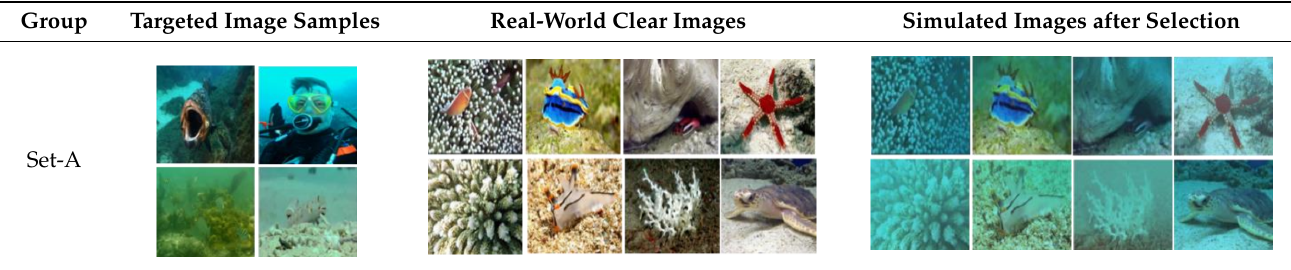
Table 3. Sample images of three training sets generated by the proposed